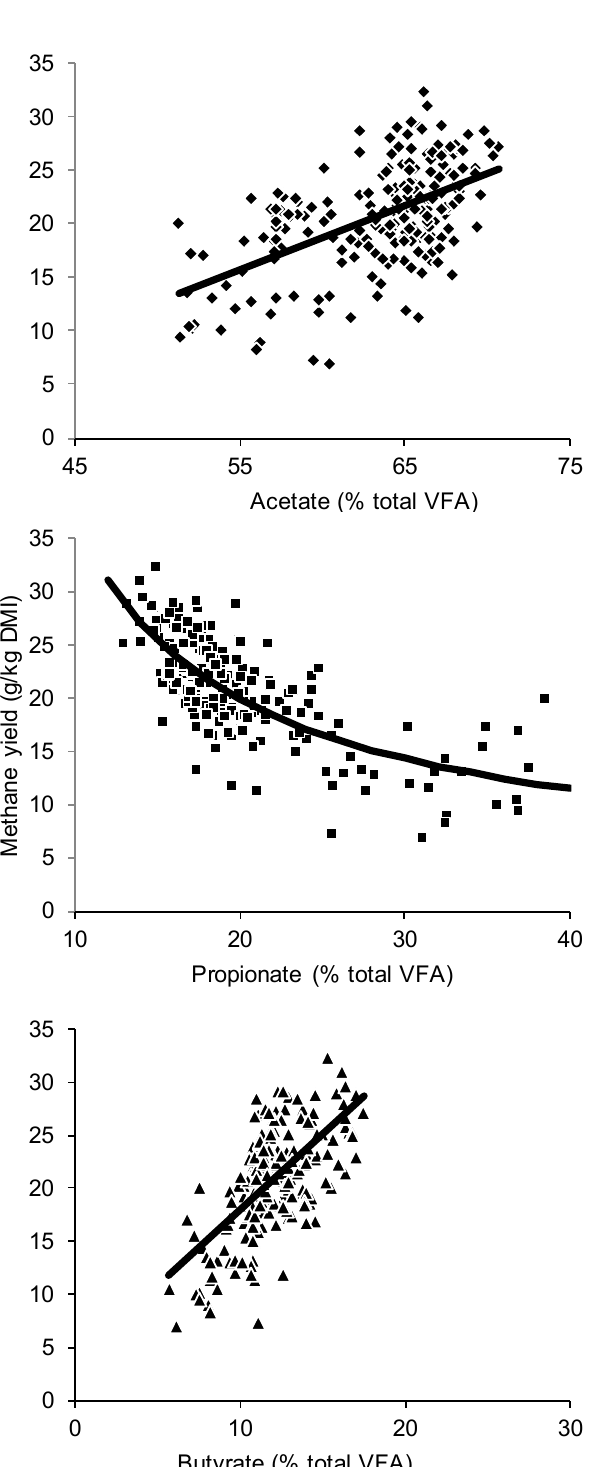
Figure 1. Methane yield (g / kg DMI) versus ruminal acetate, propionate and butyrate as mol per 100 mol of total volatile fatty acids from 215 cow records across 24 diets [24–30]. Solid lines are linear or reciprocal trend lines.